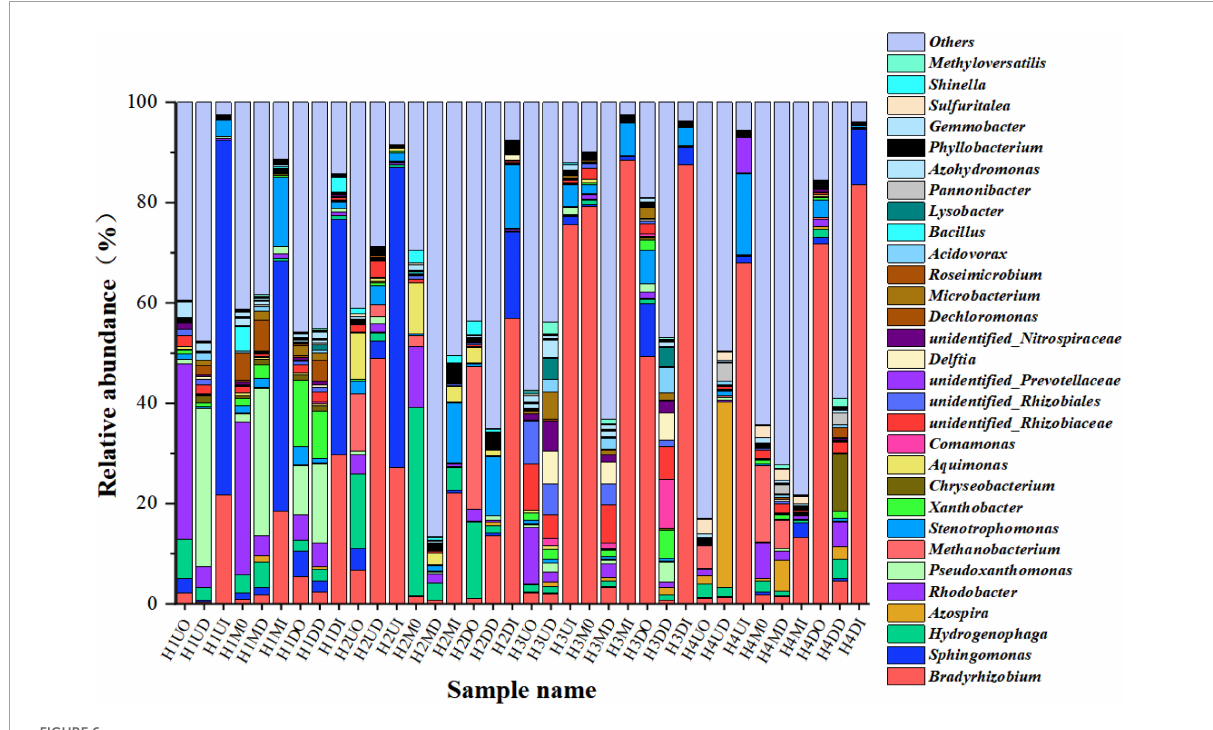
FIGURE6 A genus-level relative abundance of the top 30 dominant bacteria of